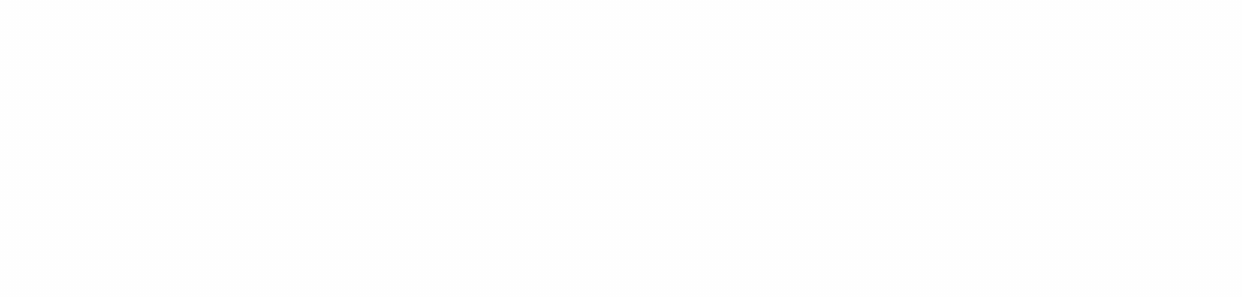
FIGURE 2 Effect of KLH-specific Thl and Th2 clones on germinal center formation to TNP-KLH in nu/nu BALB/c mice. Mice received i.v. and s.c. (in the front feet) injections of 5 106 cloned T cells (Thl clone D3 or LV3M and Th2 clone DC10). TNP-KLH was injected in the front feet in complete Freund’s adjuvant 4 hr before the cells. Mice were boosted with TNP-KLH in saline on day 10 and killed on day 15. On the left, GCs expressed as the percentages of follicles in brachial lymph nodes exhibiting GCs; on the right is the number of GCs per splenic cross-section. Evaluation of GC numbers was performed on sections stained with PNA-peroxidase followed by counterstaining with methyl green. Data are adapted from Secord et al.,